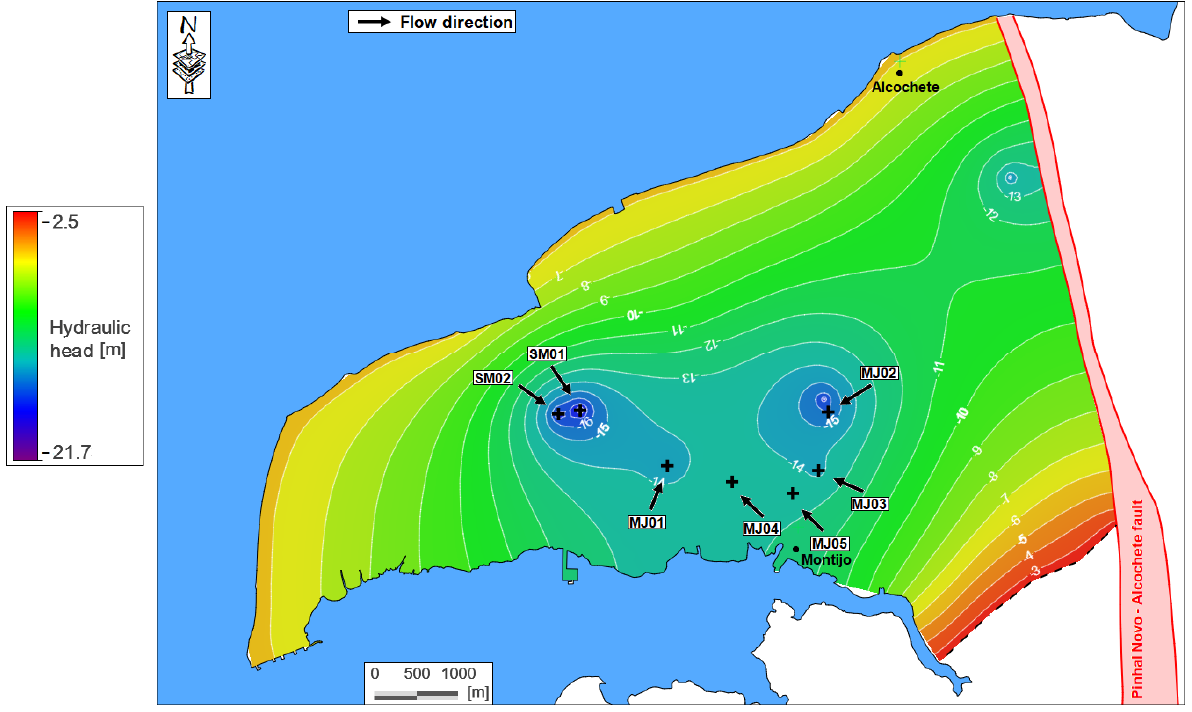
Figure 8. Piezometric surface of confined aquifer and main flow direction captured by public wells.